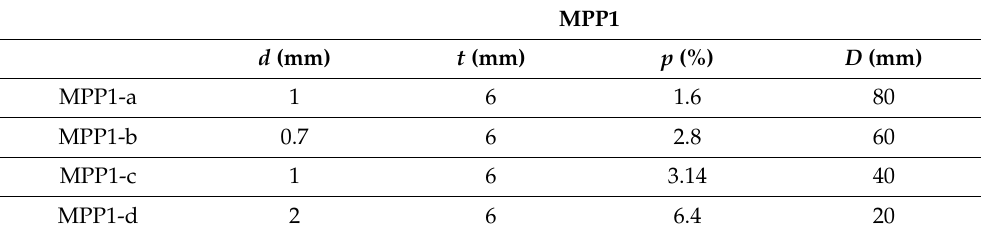
Table 1. Parameters of four parallel-arranged